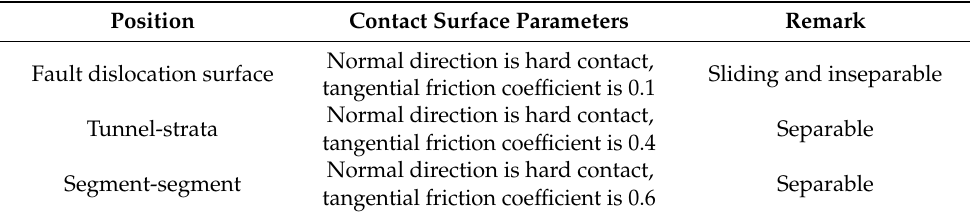
Table 3. Contact parameters in numerical